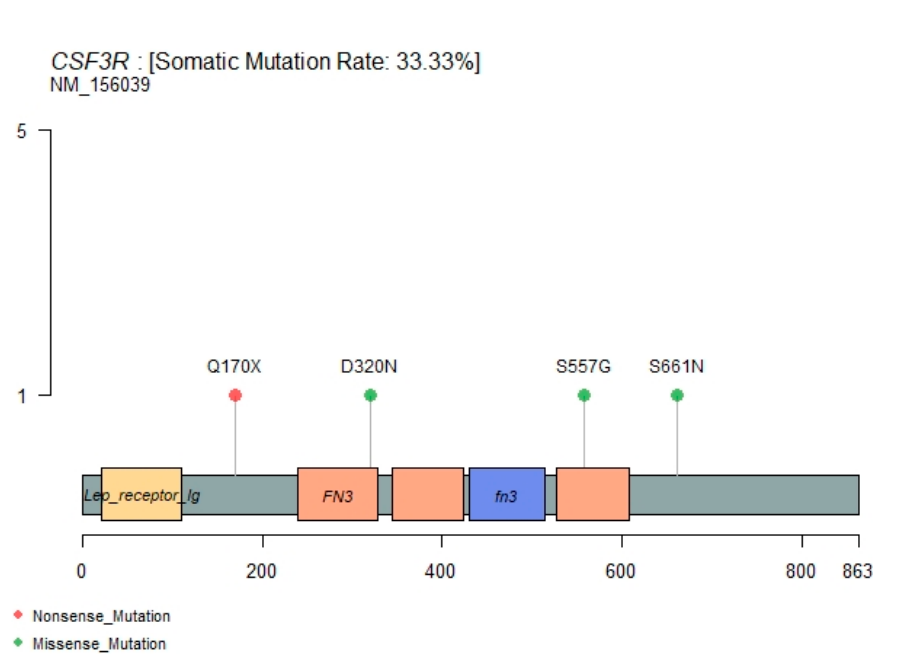
Figure 7. Lollipop plot for CSF3R